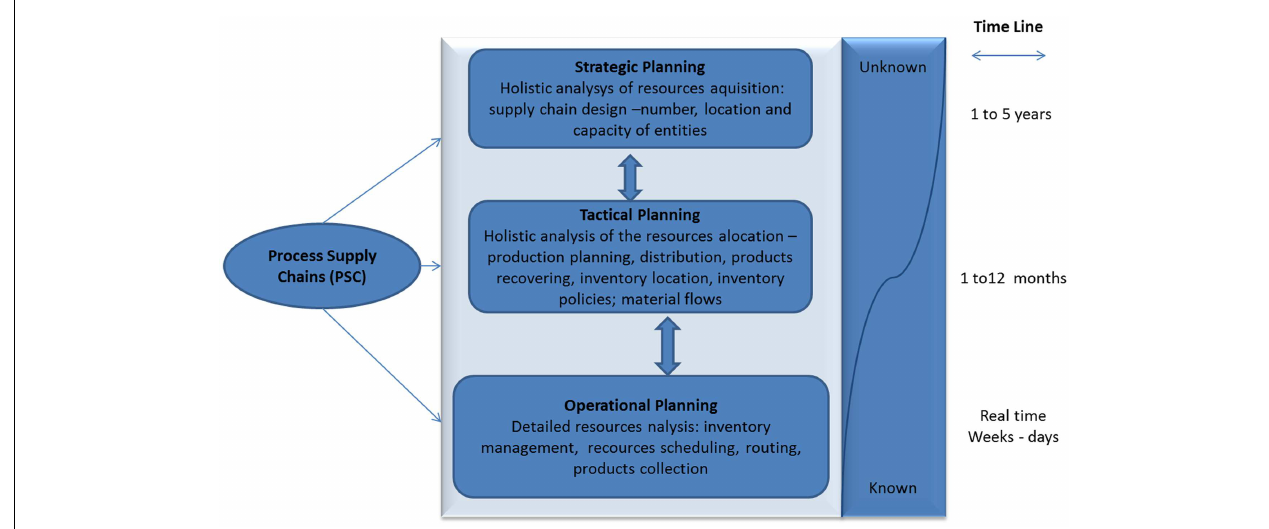
FIGURE 1 | Supply chain decision levels (adapted from Shapiro, 2001) .